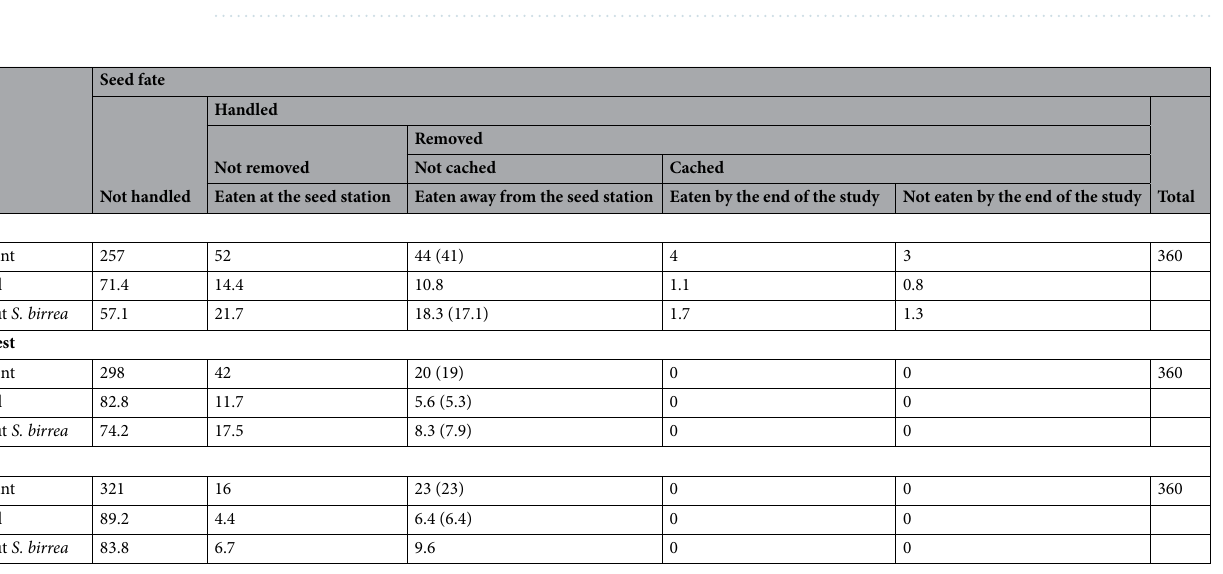
Figure 1. Cumulative percentage of seeds handled (i.e. eaten or removed) over time for ( a ) Annona squamosa , ( b ) Flacourtia ramontchi in the three different vegetation formations.